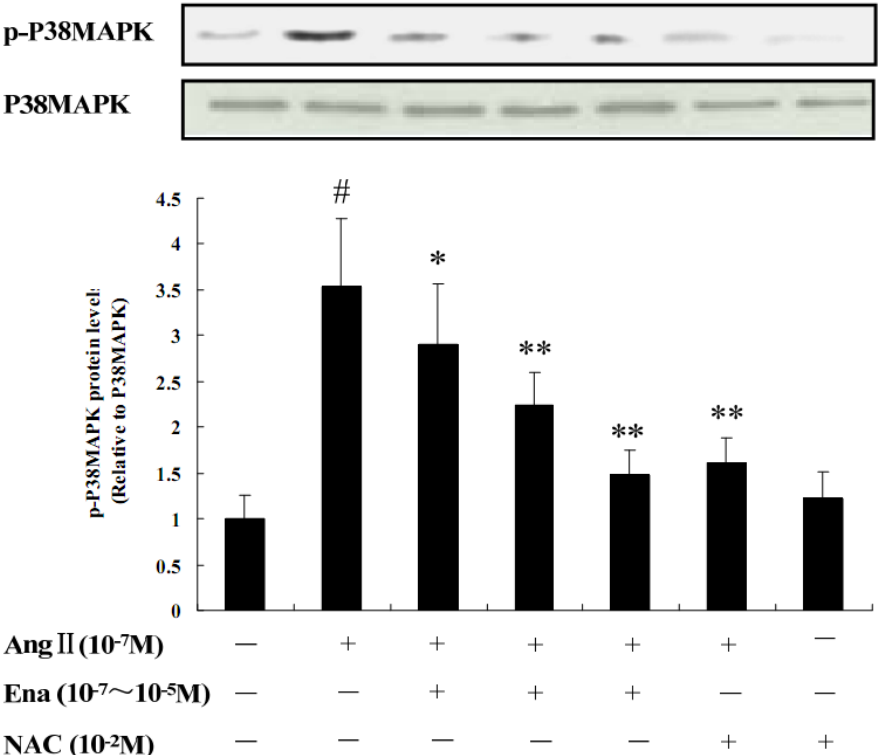
Figure 3. The Effect of Ang II, Ena. and antioxidant NAC on p-p38MAPK protein expression by Western blotting in CFb. Ang II (10 − 7 M), Ena. (10 − 7 M, 10 − 6 M, 10 − 5 M), NAC (10 –2 M, 30 minutes prior to Ang II administration). Representative blots are shown. Data are shown as relative level to the control group (p-p38MAPK protein expression level / p38MAPK = 1), Data are expressed as mean ± S.E.M. (n = 8). # P < 0.05 vs.